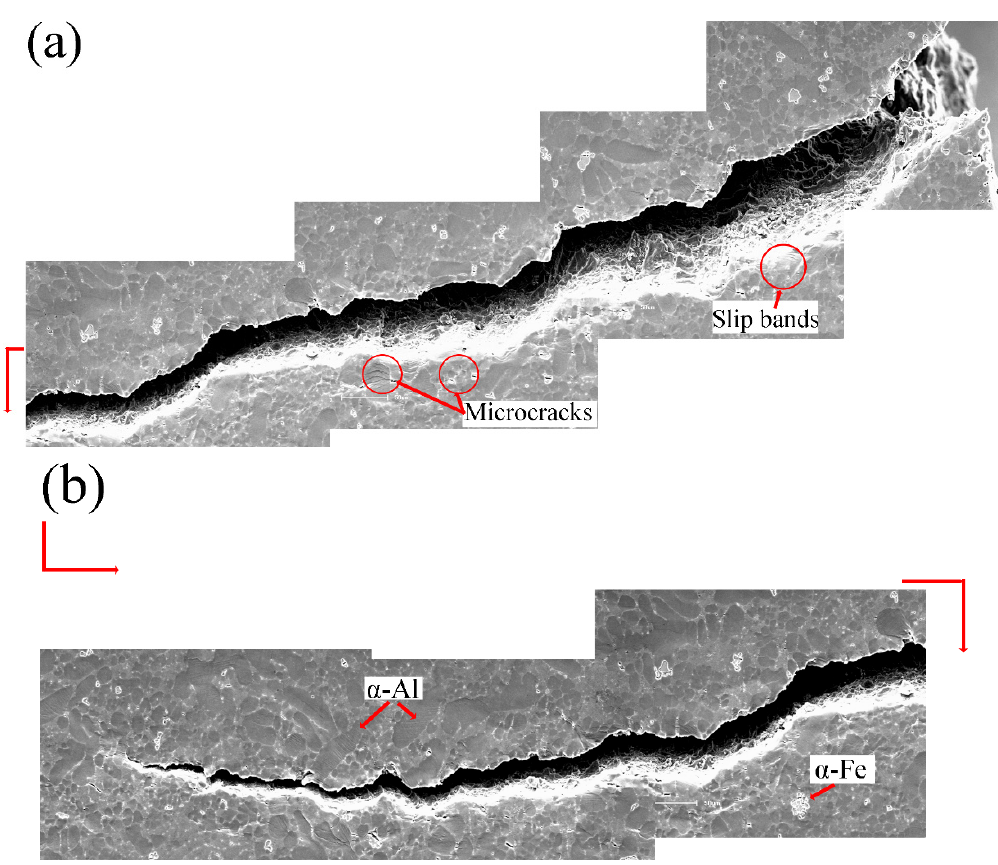
Figure 5. Crack propagation during in-situ tensile testing the as-cast alloy, showing ( a ) formation of slip-bands and microcracks initiation in α -Fe phases, ( b ) concaving of α -Al grains.